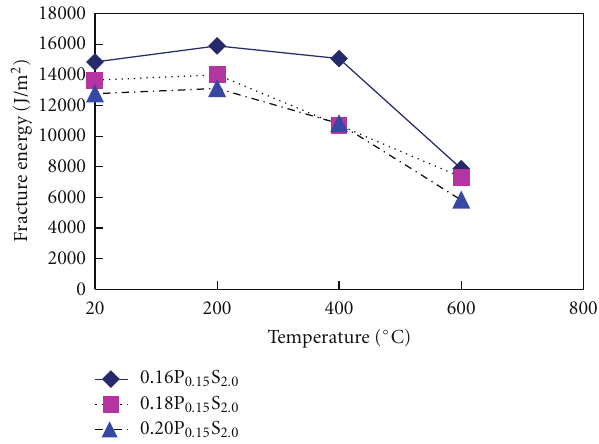
Figure 4: Residual fracture energy of RPC with di ff erent W/B